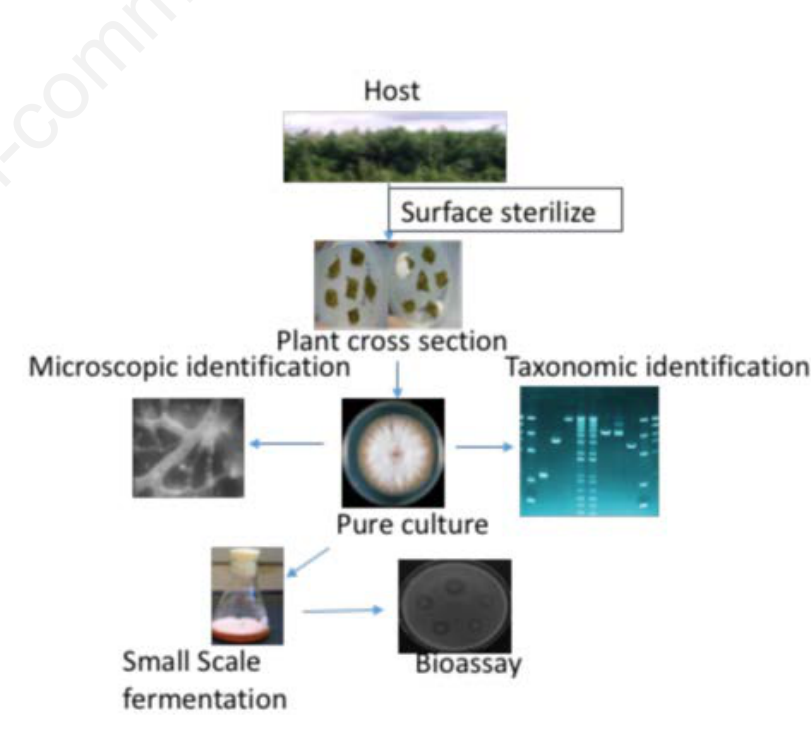
Figure 1. The interaction between endophytes and plant